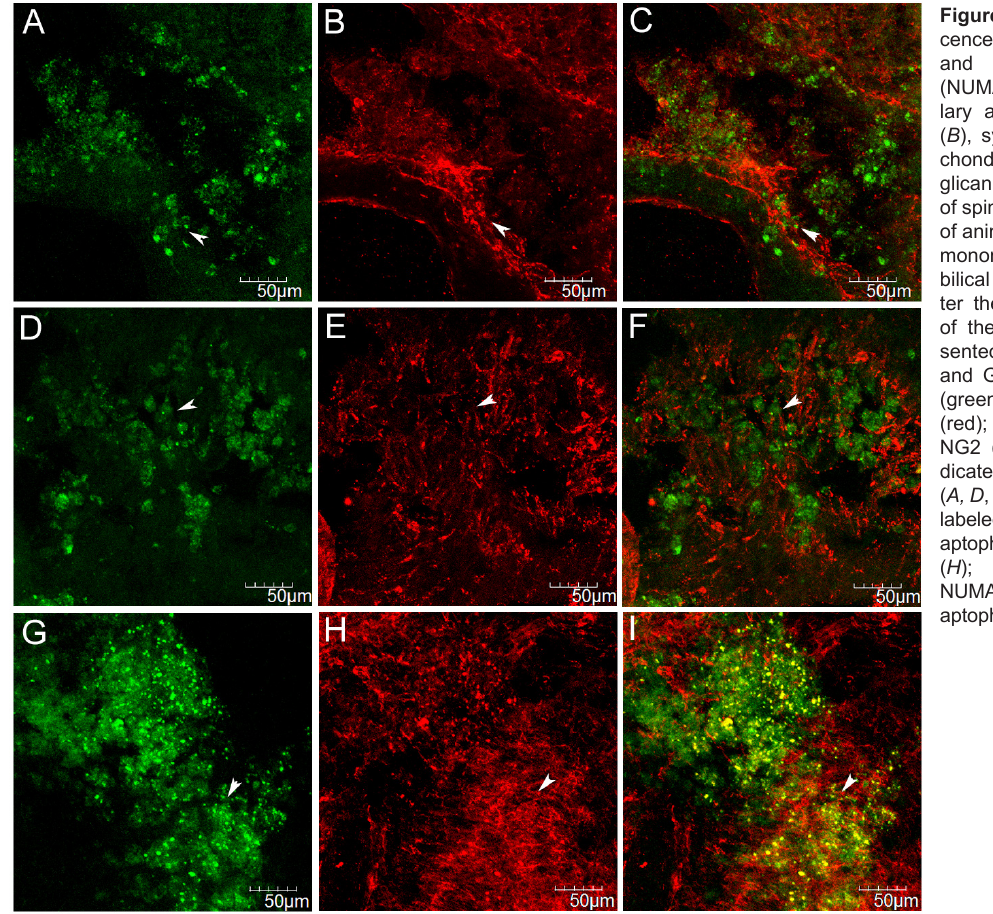
Figure 5. Immunofluores- cence staining for nucleus and mitotic cell antigen (NUMA) ( A , D , G ), glial fibril- lary acidic protein (GFAP) ( B ), synaptophysin ( E ) and chondroitin sulfate proteo- glican (NG2) ( H ) in sections of spinal cord at the T9 level of animals transplanted with mononuclear cells from um- bilical cord blood 9 days af- ter the lesion. Overlapping of the antibodies is repre- sented as: C , NUMA (green) and GFAP (red); F , NUMA (green) and synaptophysin (red); I , NUMA (green) and NG2 (red). Arrowheads in- dicate: NUMA-positive cells ( A, D , G ); positive cells when labeled with GFAP (B), syn- aptophysin ( E ), and NG2 ( H ); double-labeling with NUMA and GFAP ( C ), syn- aptophysin ( F ), and NG2 ( I